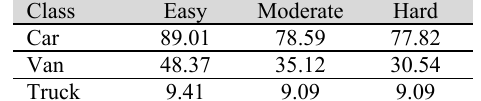
Table 3 . Achieved AP 70 values on the evaluation set of the KITTI 3D object detection dataset (Geiger et al., 2012) per class and detection difficulty (easy, moderate, hard).